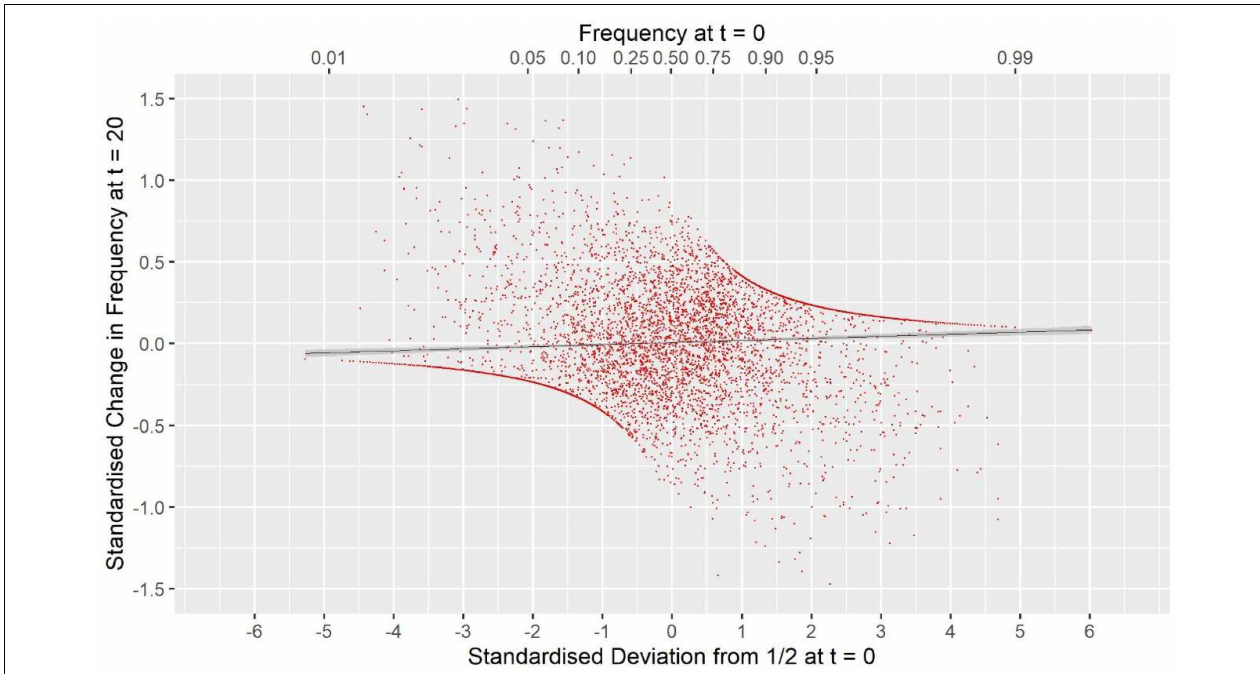
FIGURE 3 | The covariance between the standardized change in allele frequency at t = 20 and the standardize frequency at t = 0 for the 7000 SNP loci in Panel N for a randomly chosen replicate. Standardization is by p p 0 , k ( 1 − p 0 , k ) for locus k . The solid black line is the fitted linear regression y = 0.0083 + 0.0070 × , with SES 0.0042 and 0.0021, respectively, and a Pearson correlation r = 0.040. For this replicate F drift = 0.123, F hom = 0.178, and twice the covariance was 0.0555. The upper x -axis shows the untransformed